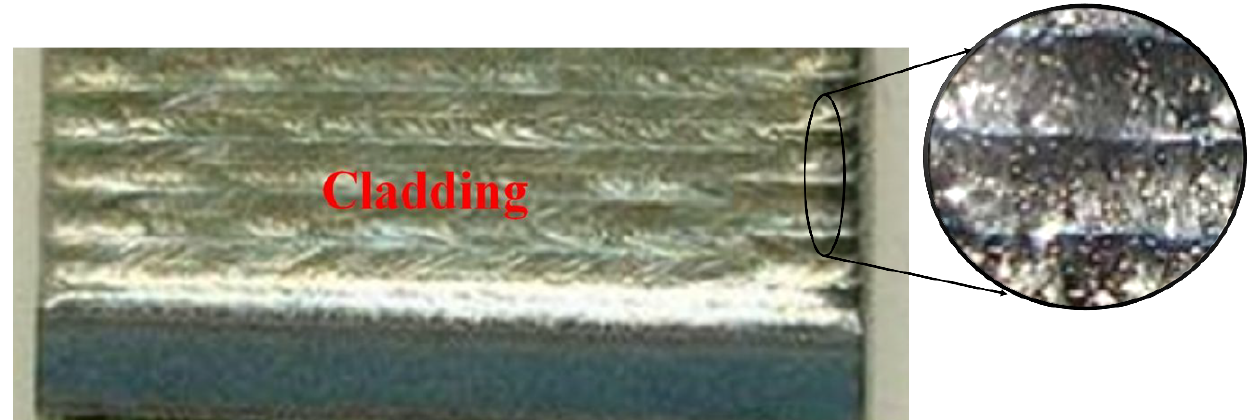
Figure 11. Side view of the morphology of laser cladding in grade 6 Stellite on carbon steel [97].